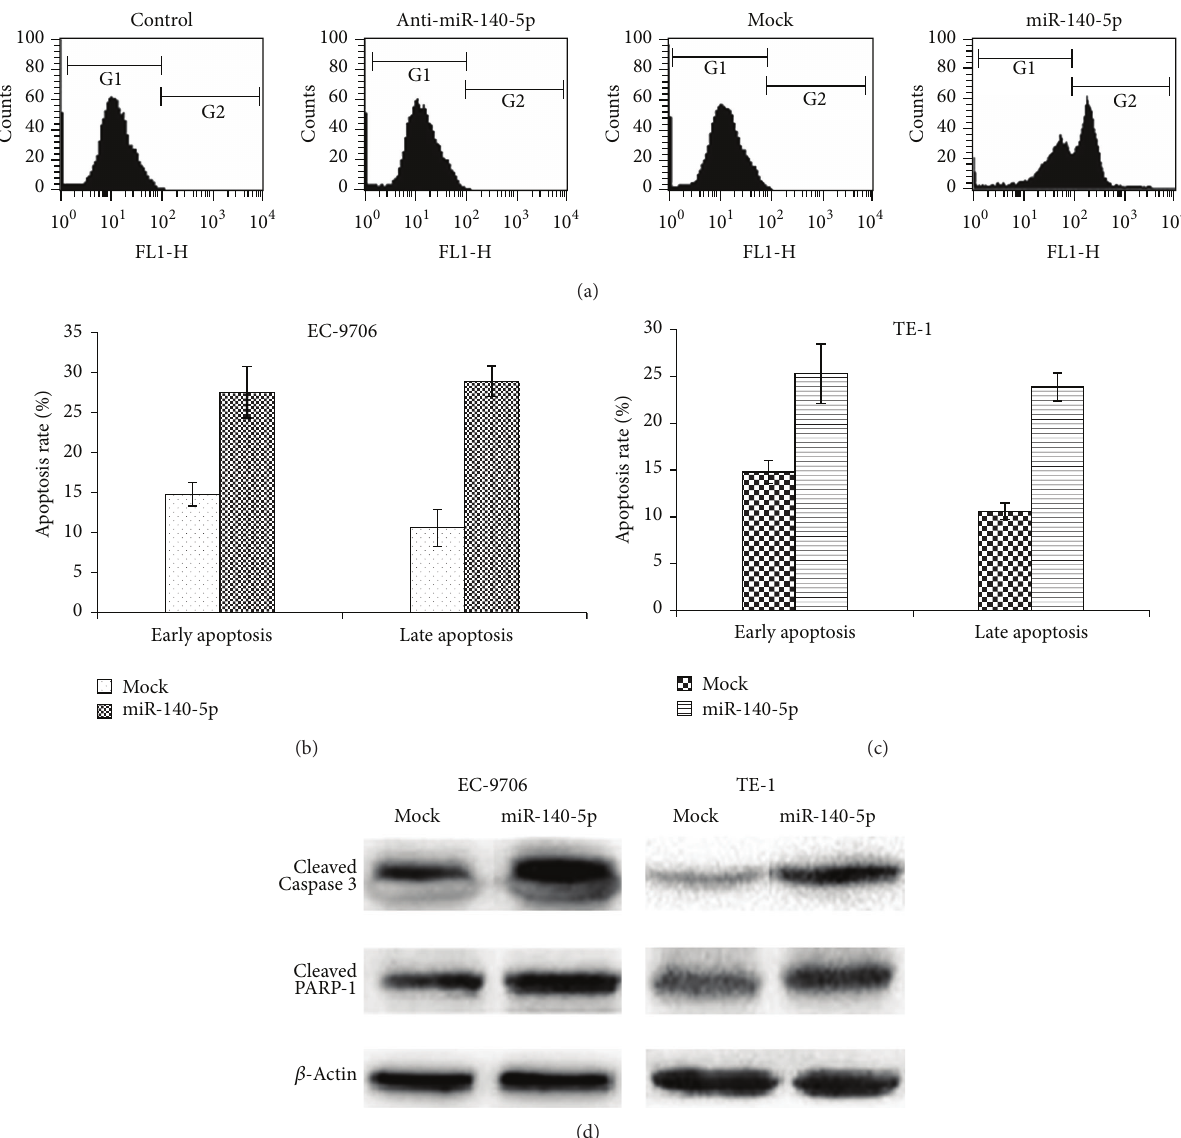
Figure 4: Analysis of effect of miR-140-5p on EC9706 cells via flow cytometer after staining with Annexin V (a). Percentage cell apoptosis was examined using flow cytometer after transfecting EC9706 and TE-1 cells with miR-140-5p (b and c). The percentage of cells in early and late apoptosis was quantified by interpretation of quadrant (UR and LR) with regard to control. The apoptosis assay was performed by staining Annexin V/PI on cells and analyzed by flow cytometry (d). The expression of apoptotic-related proteins, cleaved caspase 3, and cleaved PARP-1 was detected by western blot analysis, and 𝛽 -actin was used as a loading